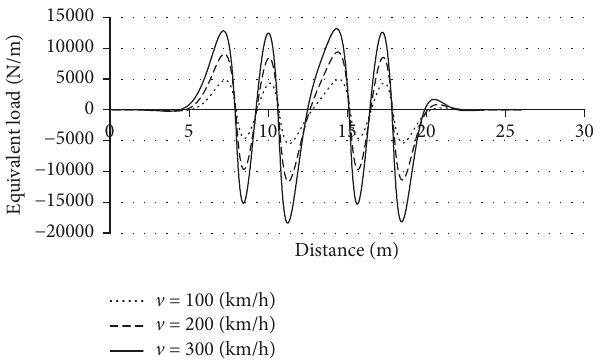
Figure 4: Equivalent load related to damping properties of rail foundation (higher values of viscous coefficients of fasteners and sleeper